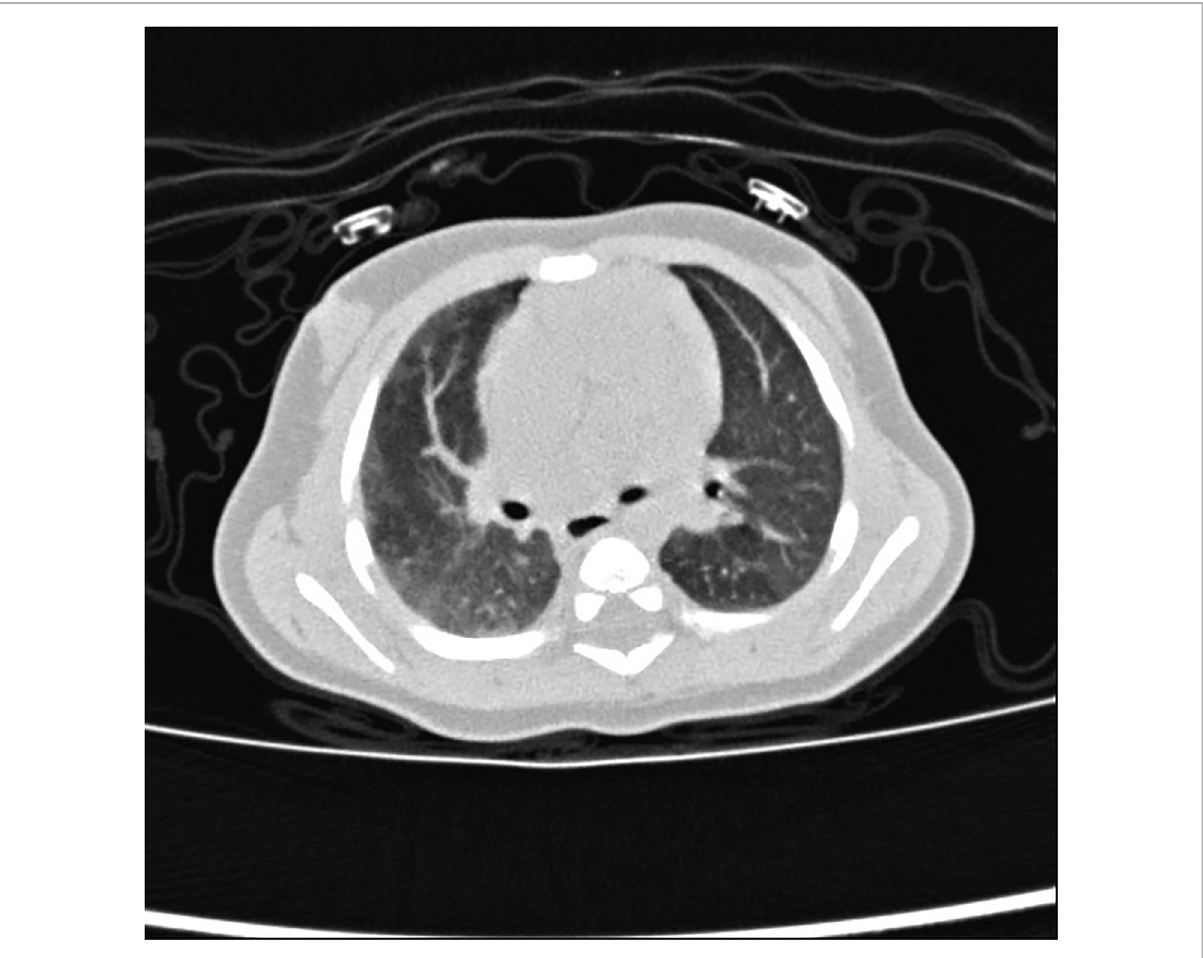
FIGURE 8 Right proximal interruption of the pulmonary artery in a 1-month-old male patient. A transverse view of a plain computed tomography scan shows strip-like shadows of subpleural pulmonary parenchyma along the periphery of the right lung at ground-glass opacity and a mild mosaic sign in the left